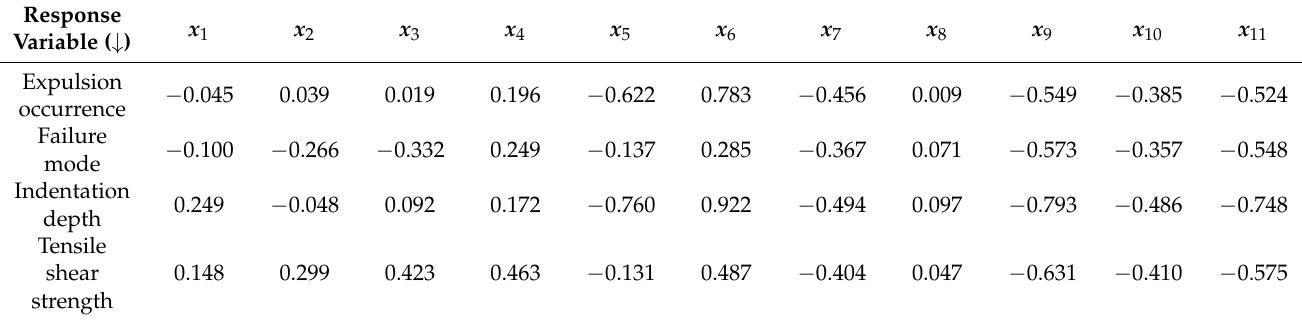
Table 4. Result of correlation